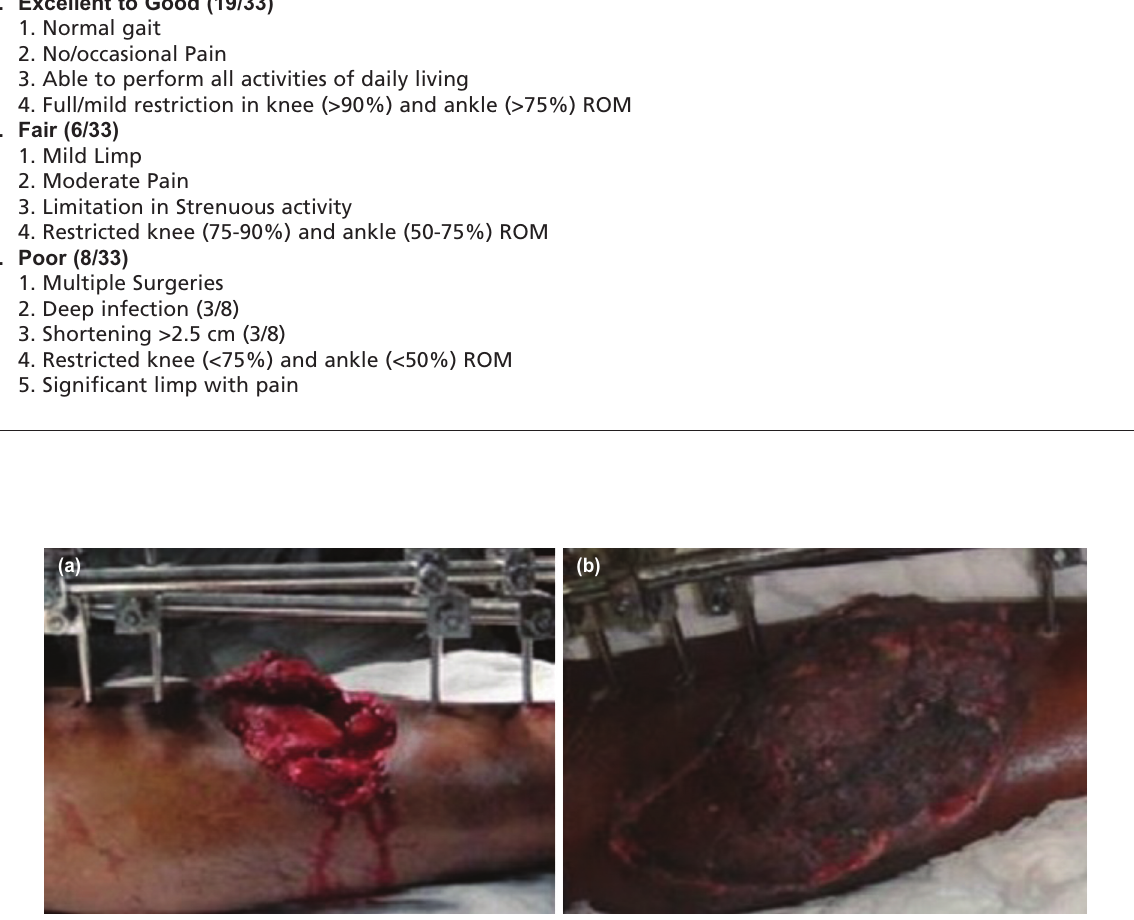
(a,b) Grade 3B open tibia fracture managed by external fixation and distant free muscle flap (Gracilis) in the same sitting. Fig. 1: